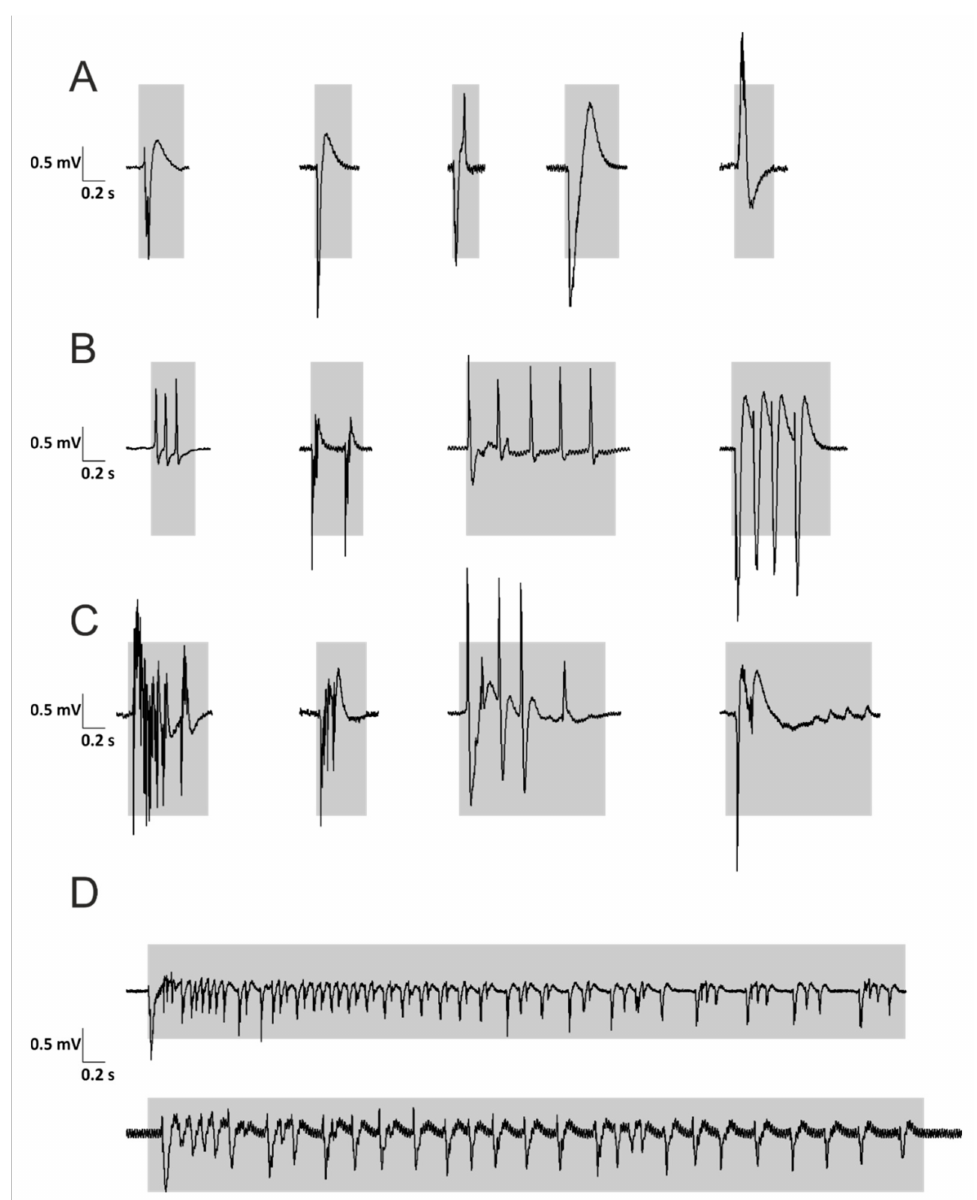
Figure 2. Morphology of REDs in all experimental groups. Depending on the pattern and duration of the potentials, we could distinguish four di ff erent types of REDs: interictal-like single monomorphic ( A ), repetitive monomorphic ( B ), and polymorphic discharges ( C ) as well as ictal-like discharges ( D ). Ictal-like discharges were only obtained in gabazine-containing ACSF. The durations of REDs are highlighted in